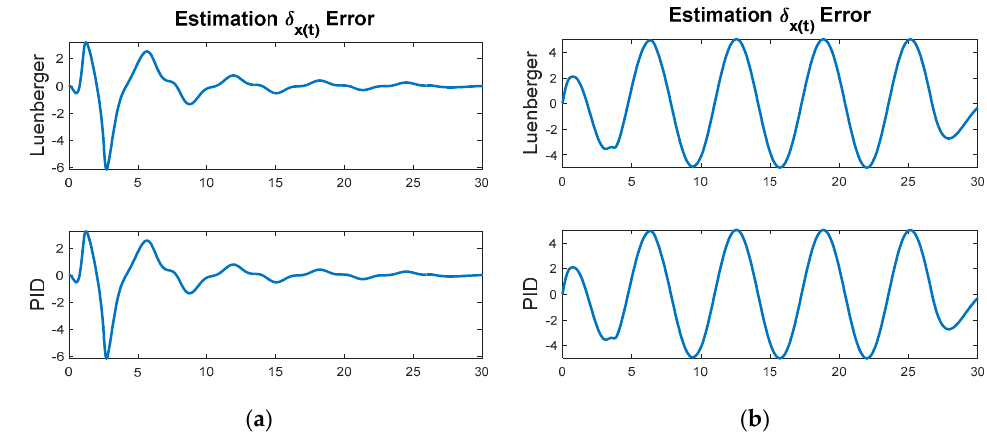
Figure 10. ( a ) Estimation error using dual feedforward & feedback control. ( b ) Estimation error using only ideal, nonlinear feedforward control (notice poor estimation is not relevant since feedforward control does not use these estimates).